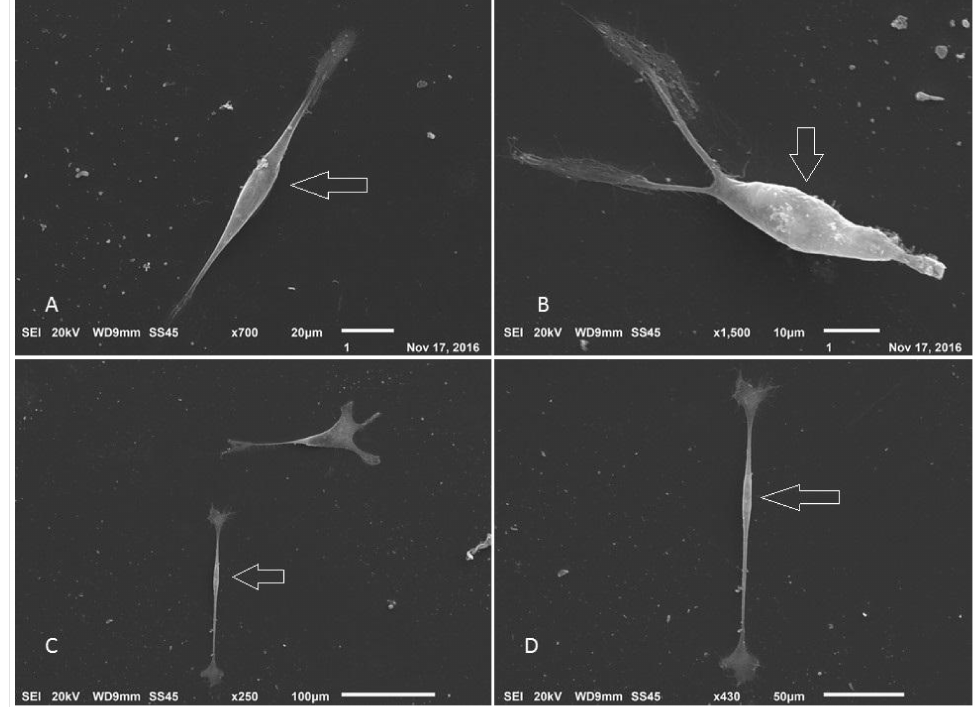
Figure 16. Scanning electron microscopy of GABAergic differentiation. ( A – D ) Arrows point to cells with neural characteristics (Jeol JFM—6010,